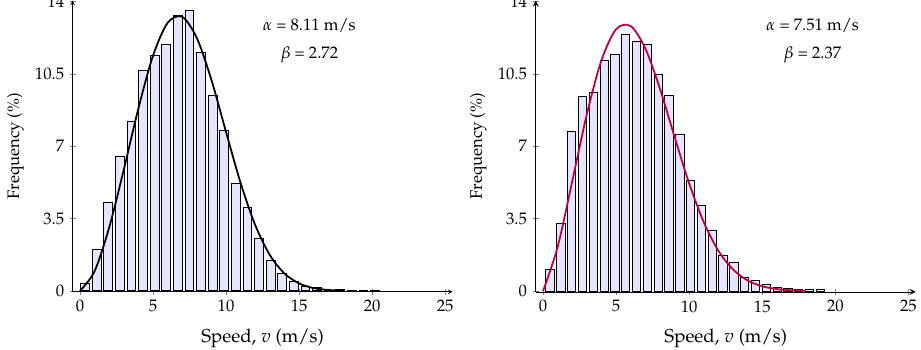
Figure 10. Frequency distribution for Springbok (left) and Beaufort West (right).